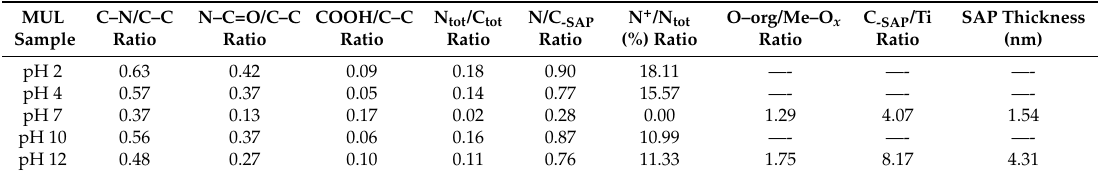
Table 2. Atomic ratios of the species present on the multilayer (MUL) Self Assembling Peptide (SAP) surface. N + : protonated nitrogen; Me–O x : oxygen of metal oxides; O–org: organic oxygen.